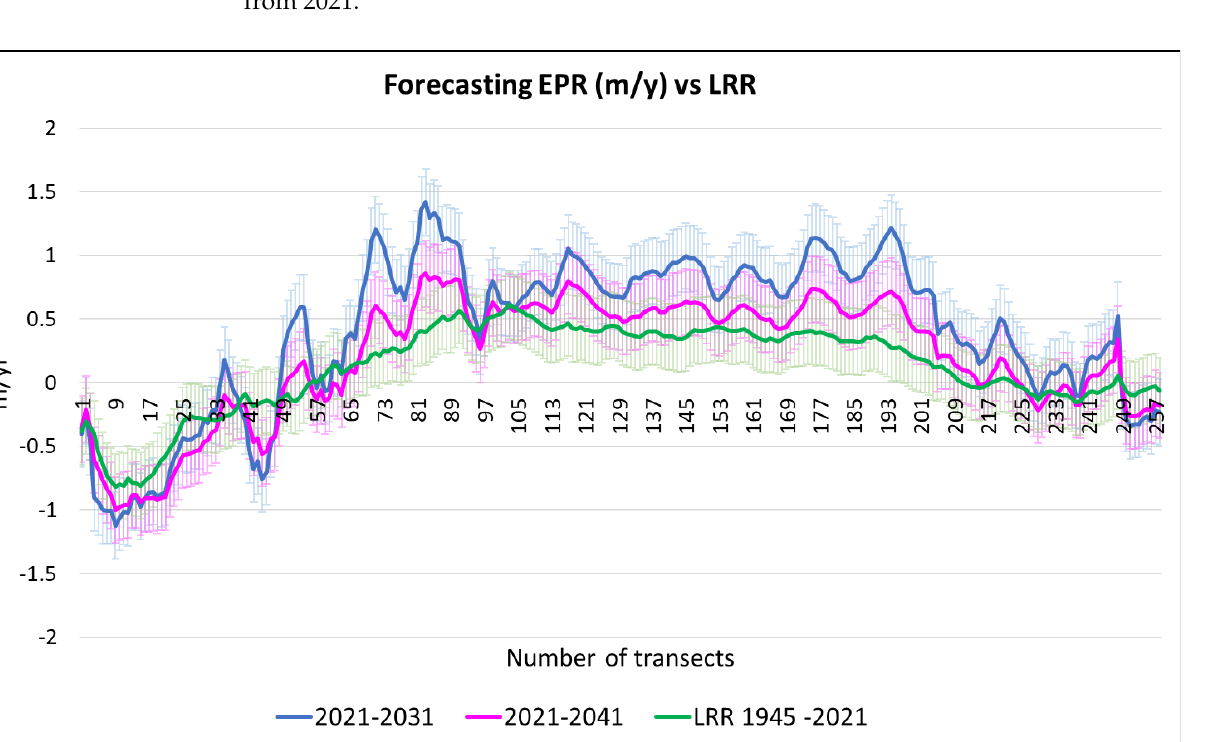
Table 6. The estimated errors of the EPR correlation for the 2021 – 2031 and 2021 – 2041 periods com- pared to the 1945 – 2021 LRR rates. Estimated Errors